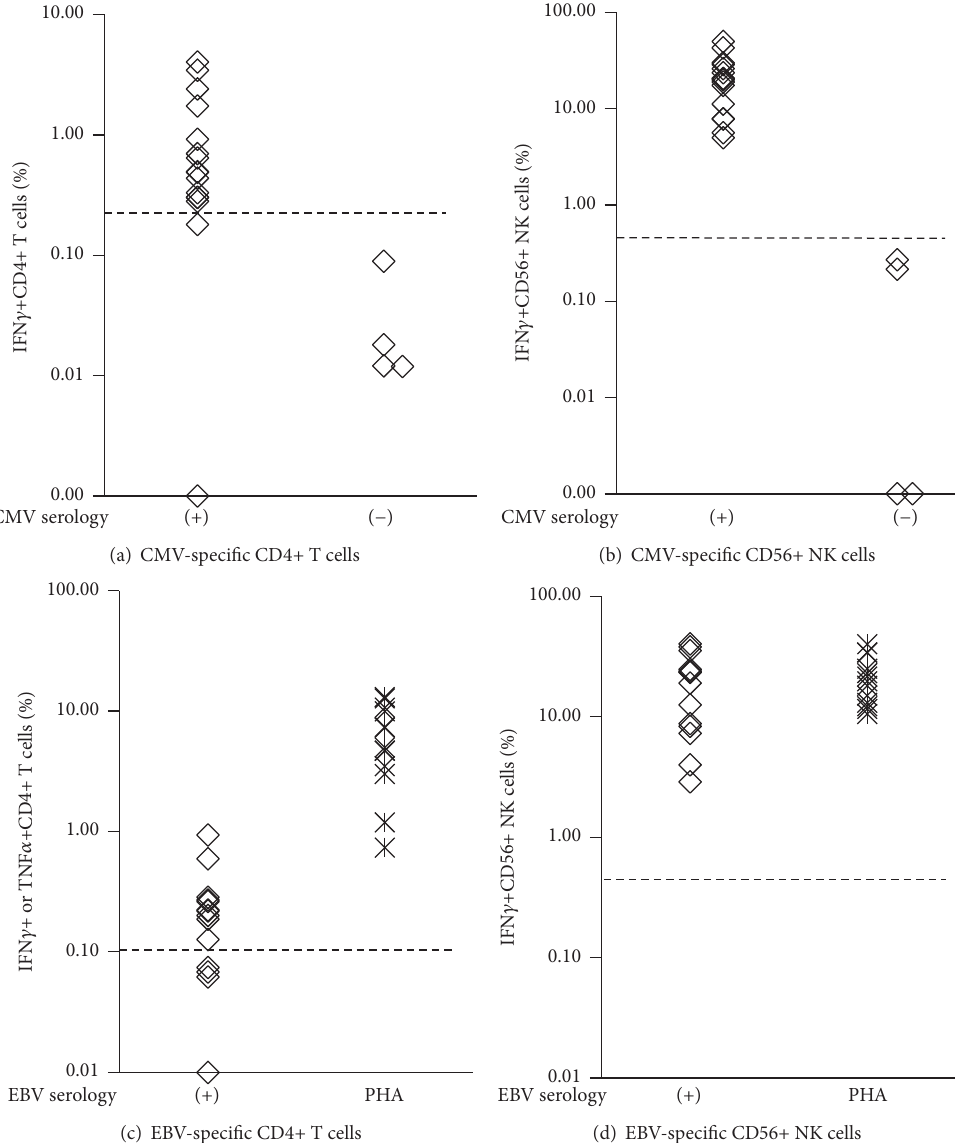
Figure 5: The levels of CMV-specific CD4+ T cells (CMV-Th) (a) and CD56+ NK cells (CMV-NK) (b) in 16 CMV sero(+) and 4 sero( − ) normal individuals and EBV-specific CD4+ T cells (EBV-Th) (c) and CD56+ NK cells (EBV-NK) (d) in 14 EBV sero(+) normal individuals as analyzed by CFC. Each symbol represents the result from one individual. The dotted line describes the positive cutoff level; ≥ 0.2% for CMV-Th, ≥ 0.1% for EBV-Th, and ≥ 0.5% for CMV- and EBV-NK. The PHA (+) control results were also shown in (c) and